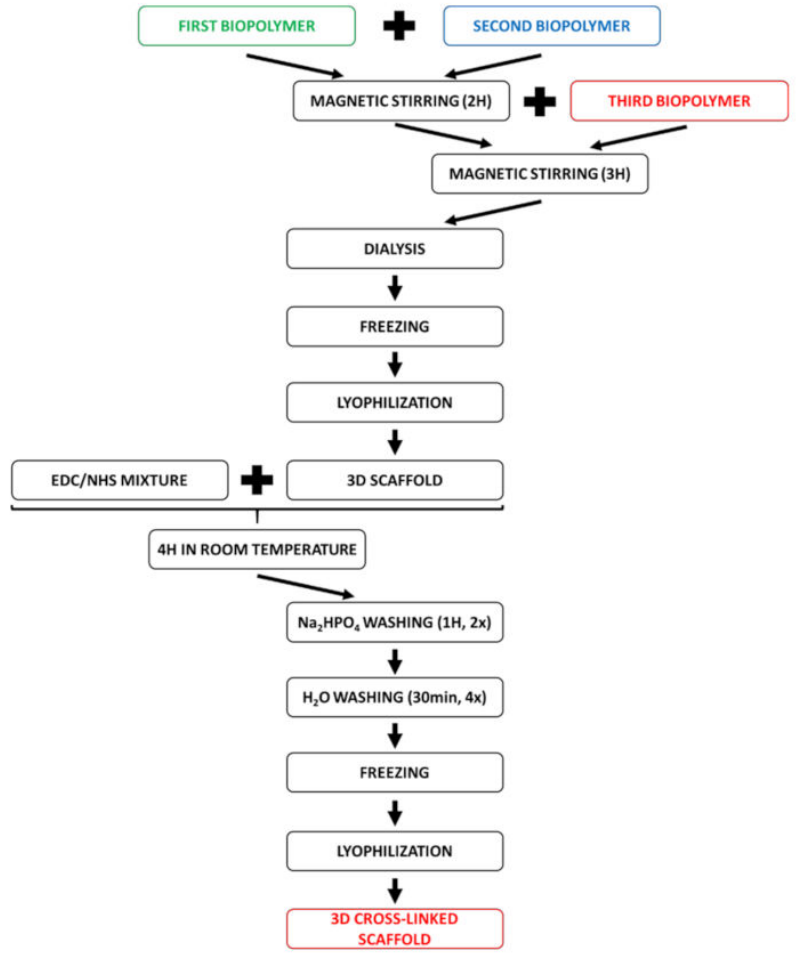
Figure 3. The scheme of preparing and cross-linking biopolymeric